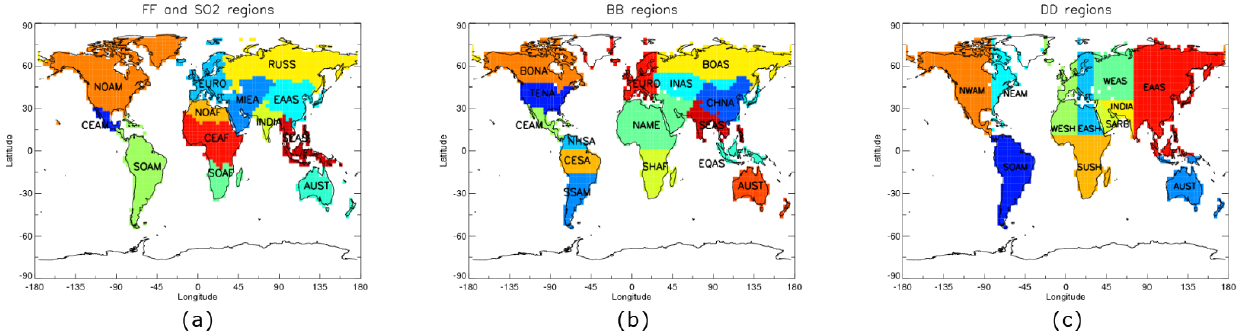
Fig. 1. Definition of emission regions used in the control vector for SO 2 and the different aerosol species. (a) Thirteen regions are defined for emissions of both SO 2 and other FF aerosols: North, Central and South America (NOAM, CEAM, and SOAM, respectively), Europe (EURO), North, Central and South Africa (NOAF, CEAF, and SOAF, respectively), Middle East (MIEA), Russia (RUSS), India (INDIA), East Asia (EEAS), South East Asia (SEAS) and Australia (AUST). (b) Fifteen regions are defined for BB aerosol emissions: Boreal North America (BONA), Temperate North America (TENA), Central America (CEAM), Northern Hemisphere South America (NHSA), Central South America (CESA), Southern South America (SSAM), Europe (EURO), North Africa and Middle East (NAME), Southern Hemisphere Africa (SHAF), Inner Asia (INAS), Boreal Asia (BOAS), China (CHNA), South East Asia (SEAS) Equatorial Asia (EQAS) and Australia (AUST). Biomass burning regions are based on GFED regions (Sect. 2.3). (c) Eleven regions are defined for dust emissions: North West America (NWAM), North East America (NEAM), South America (SOAM), Western Sahara (WESH), Eastern Sahara (EASH), Sub-Sahara (SUSH), Western Asia (WEAS), India (INDIA), Saudi Arabia (SARB), East Asia (EAAS) and Australia